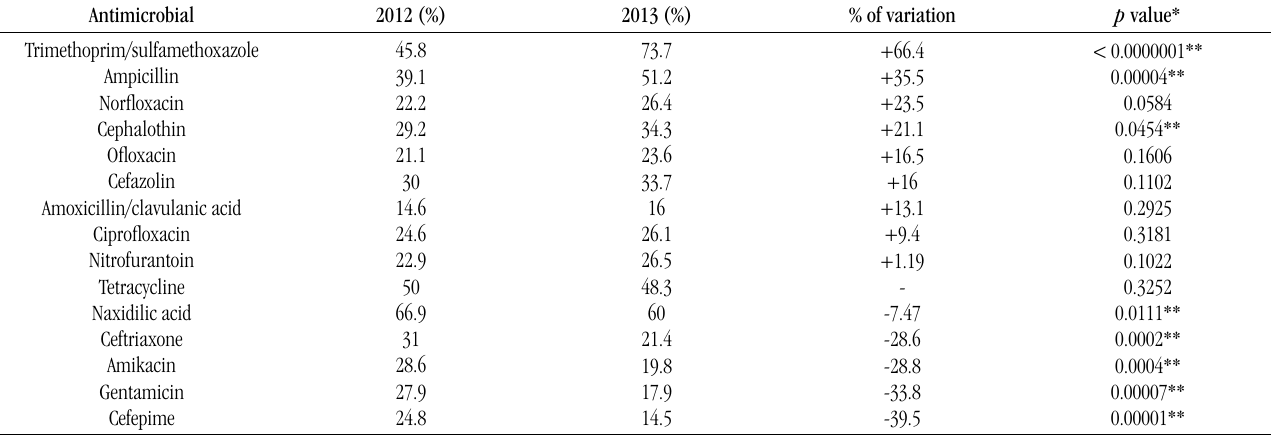
tABLE 2 – Variation in the antimicrobial resistance profile of bacteria isolated from the urine of patients seen at CIS-COMCAM between 2012 and 2013 Antimicrobial 2012 (%) 2013 (%) p